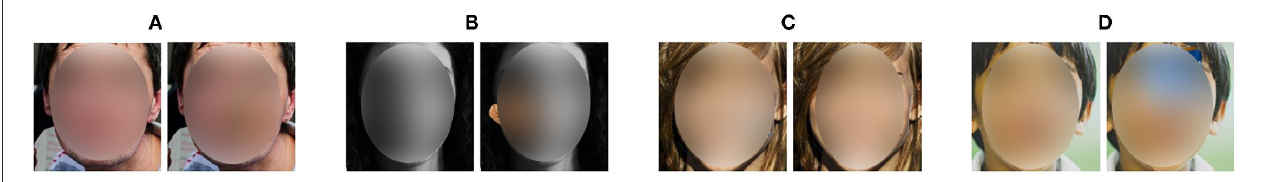
FIGURE 3 | Examples of the synthesized occluded images. The occluders are various in shape, color, and facial positions. (A) Anger, (B) neutral, (C) happy, and (D) sad.